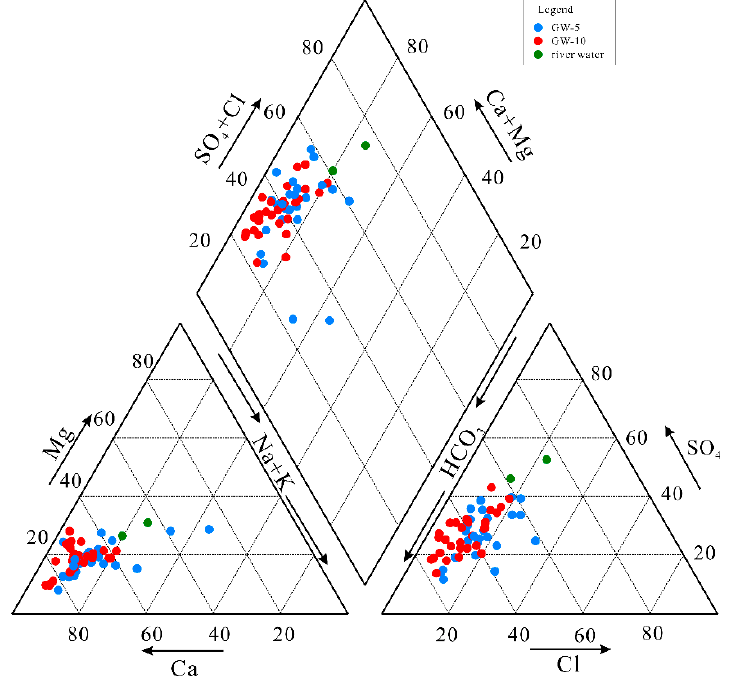
Figure 4. Piper diagram of water samples in Jinan. Water 2019 , 11 , x FOR PEER REVIEW